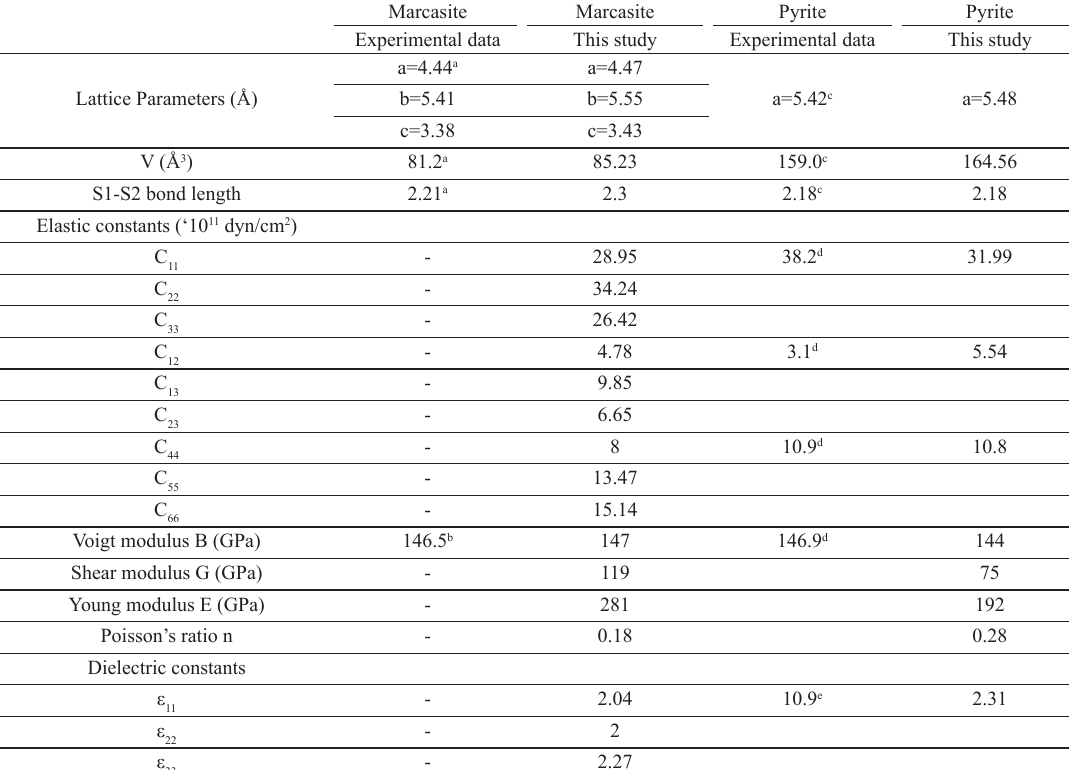
Table 2. Structural parameters, elastic and dielectric properties of marcasite and